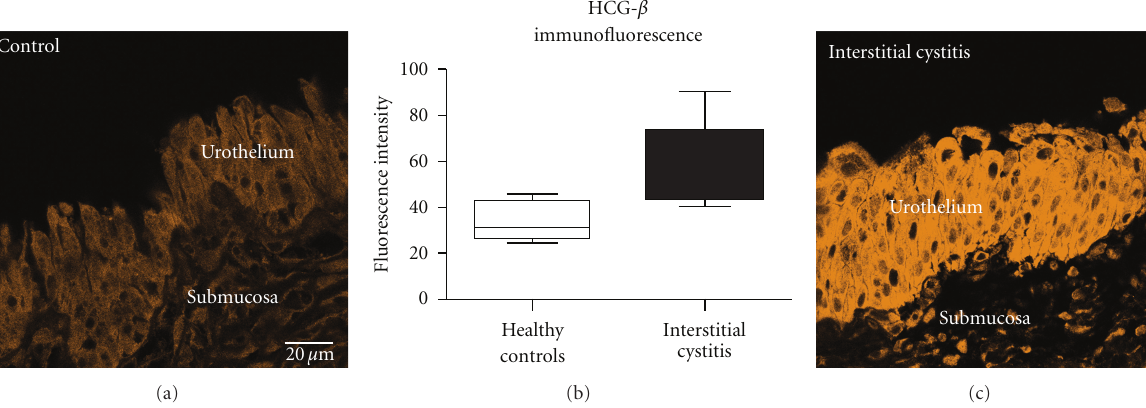
Figure 5: HCG-beta (beta-2 epitope) immunoreactivity in urothelium. (a) Control bladder from a 36-year-old woman, gynecologic tumor, no bladder carcinoma; (c) BPS/IC bladder of a 53-year-old woman showing extreme upregulation of HCG-beta; bar in (a) applies to (a and b); (c) Quantitative analysis revealed significant di ff erences between female controls ( n = 5) and female BPS/IC ( n = 10) patients (Mann-Whitney test, P < 0 .